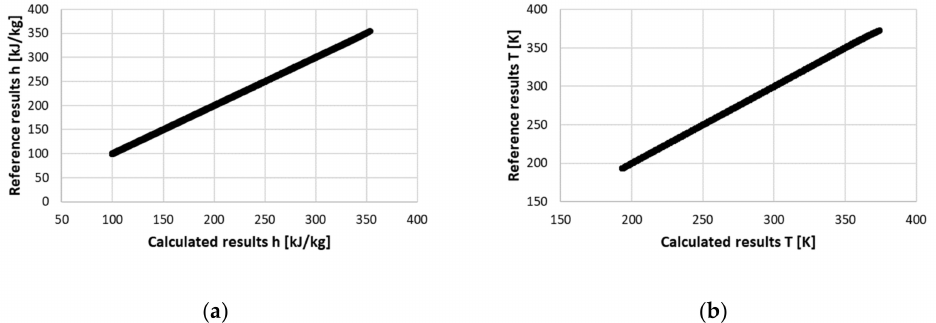
Figure 5. Comparison of the reference results and calculated results for subcooled liquid: ( a ) Specific entropy; ( b ) Temperature.